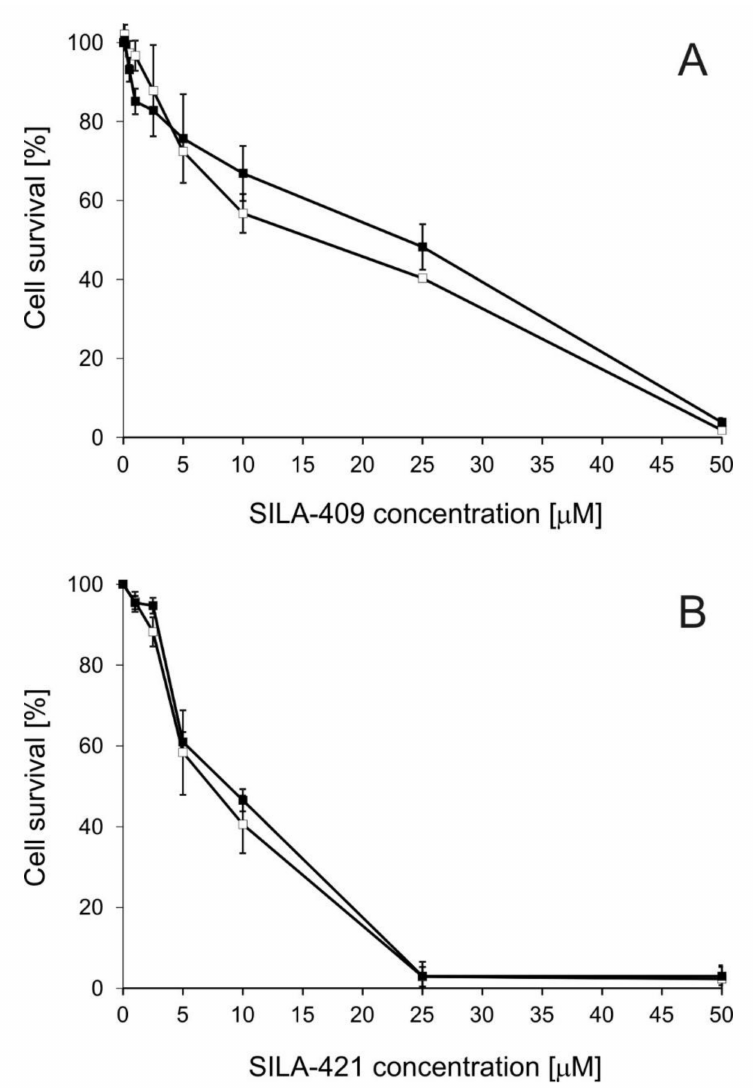
Figure 1. Cytotoxicity of SILA-409 ( A ) and SILA-421 ( B ) to LoVo (open symbols) and LoVo / Dx cells (full symbols). Means of three experiments ± SD are